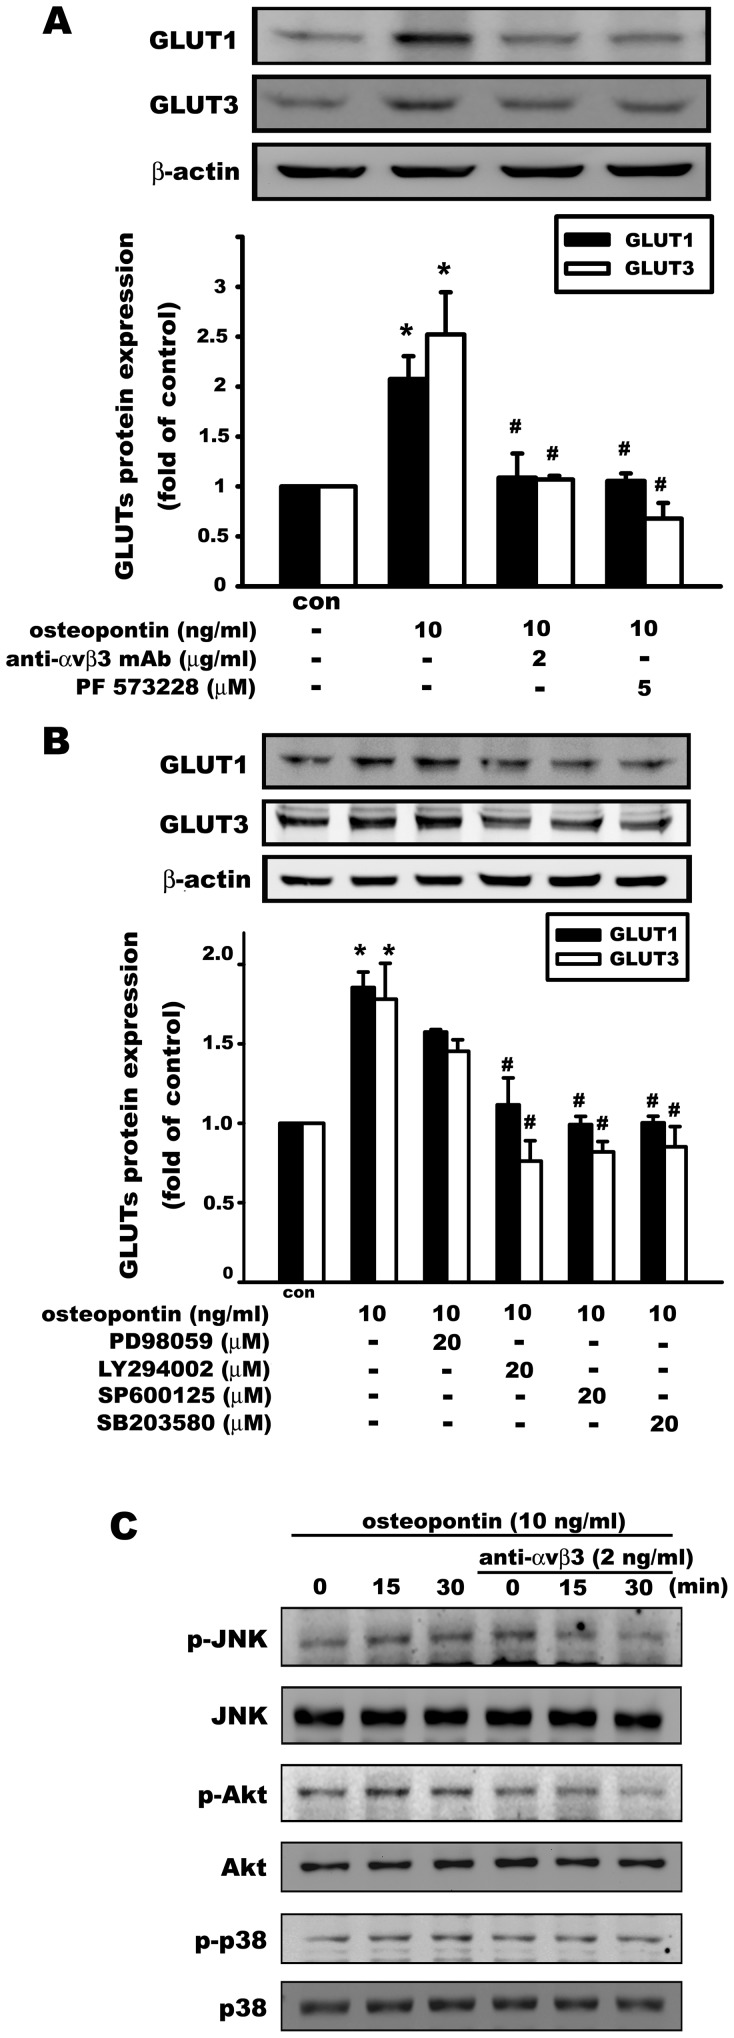
Osteopontin regulates GLUT1 and GLUT3 expression via the αvβ3 integrin and MAPK pathways in osteosarcoma cells.OPN (10 ng/ml) increased GLUT1 and GLUT3 protein expression in MG63 cells. This effect was significantly antagonized by pretreatment with an anti-αvβ3 mAb (2 µg/ml) and PF573228 (5 µM, FAK inhibitor) (A). (B) MG63 cells were pretreated with PD98059 (20 µM), LY294002 (20 µM), SP600125 (20 µM), and SB203580 (20 µM) for 30 min and then stimulated with OPN (10 ng/ml, 24 h). OPN-induced increase of GLUT1 and GLUT3 protein expression was significantly antagonized by LY294002, SP600125, and SB203580. (C) OPN (10 ng/ml) increased the phosphorylation of AKT, JNK, and p38 in a time-dependent manner, and pretreatment with an anti-αvβ3 mAb (2 µg/ml) inhibited OPN-induced AKT, JNK, and p38 phosphorylation. Data are presented as the mean ± S.E.M. (n = 3). *p≤0.05, compared with the control group (con), #p≤0.05, compared with OPN treatment alone.